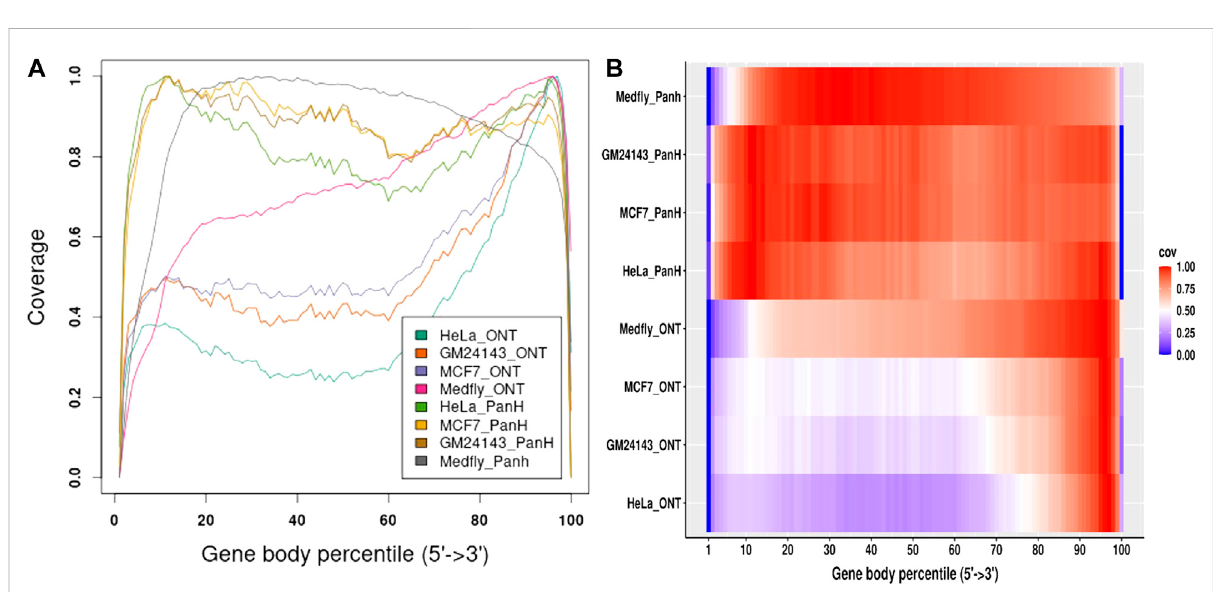
FIGURE 4 Gene body coverage comparison between ONT and Panhandle protocols. Total RNA from three human-derived cell lines (MCF7, HeLa, and GM24143, andMediterraneanfruit fl yembryos)wasprocessed both withtheONTprotocol(SQK-PCB109,Oxford NanoporeTechnologies) andour in-house optimised protocol called Panhandle. One million subsampled Pass adapter and poly (A) tailed trimmed reads were aligned to the respectivegenomesandgenebodycoverageassessedusingRSeQC(Wangetal.,2012). (A)